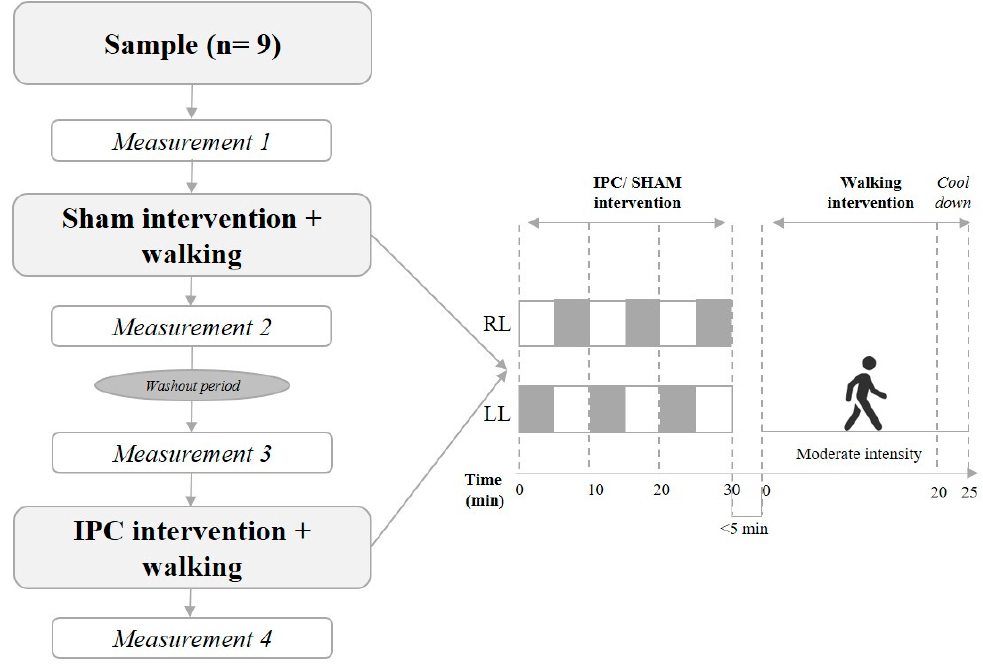
Figure 1. Protocol of the study. IPC = ischemic preconditioning; RL = right leg; LL = left leg. Grey square boxes represent 5 min arterial or sham occlusion, alternated by 5 min reperfusion (white boxes).